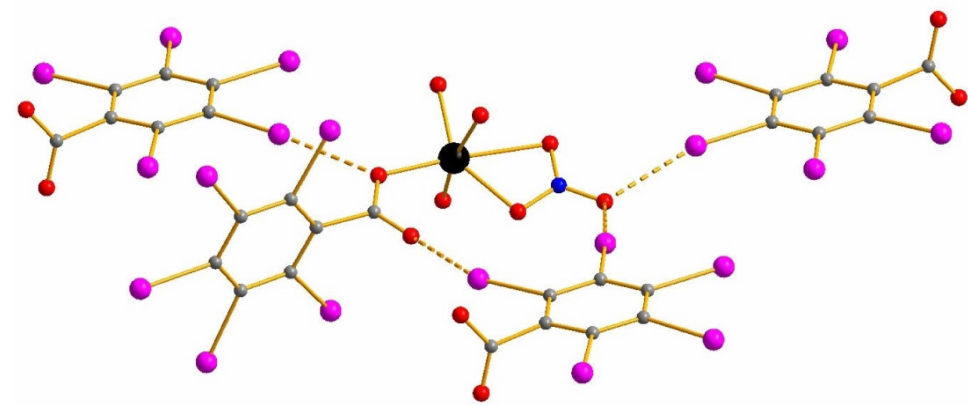
Figure 5. The system of I–O interactions (dashed) in the structure of 2 . Only O atoms of DMF ligands are